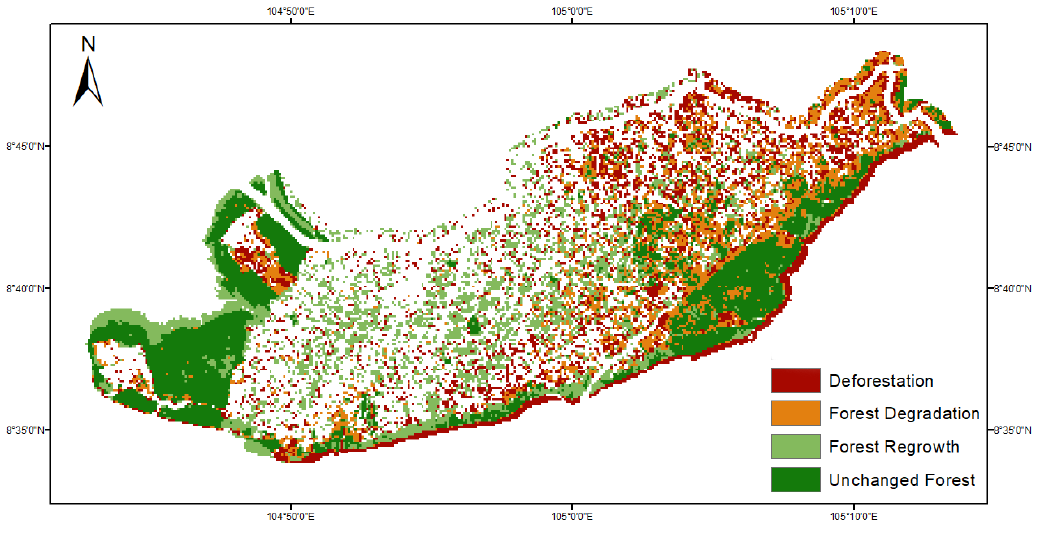
Figure 5. Mangrove forest trend map (2001–2019) of 150 × 150 m box averages.